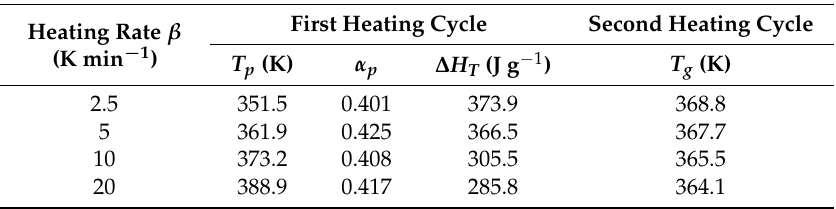
Table 3. Parameters corresponding to DSC characterization of a partially bio ‐ based epoxy system at different heating rates. First heating cycle: DSC characterization of the curing/crosslinking of the liquid resin, and second heating cycle: DSC characterization of the cured resin.